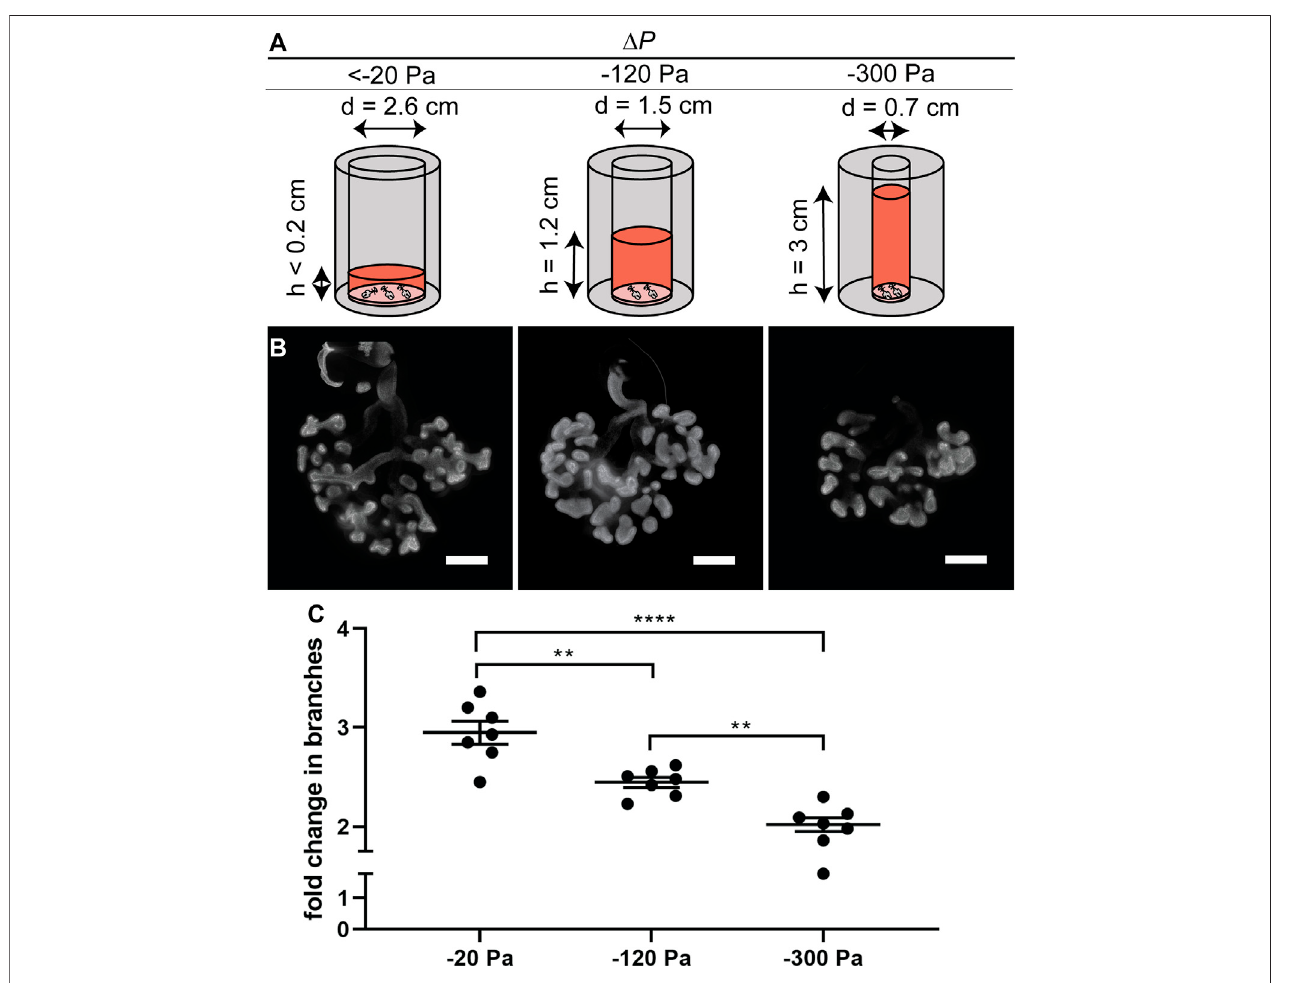
FIGURE 3 | Effect of negative transpulmonary pressure on branching of explants held under isovolumetric conditions. (A) Schematic of culture setup for isovolumetric negative transpulmonary pressure. (B) Immuno fl uorescence analysis for E-cadherin in lung explants cultured for 48 h under indicated transpulmonary pressures. (C) Foldchangeinnumberofbranchesafterculturefor48 hundertheindicatedtranspulmonarypressures(N (cid:1) 3experimentalreplicates;7explants/group). Scale bars, 200 µm.